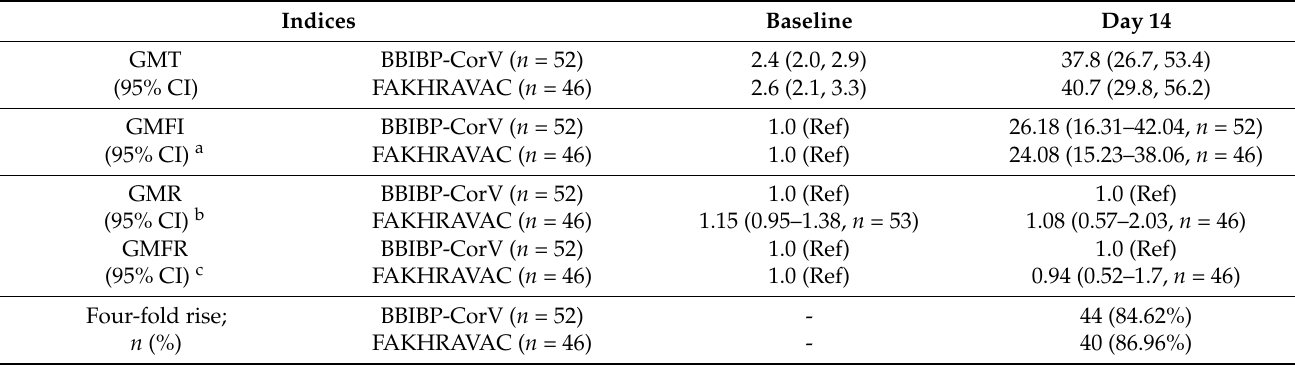
Table 3. Serum neutralizing antibody indices in seronegative group. a The geometric mean of the amount of antibody in each vaccine was divided by the amount of antibody in the baseline (i.e., Ref) day in the same vaccine group. b The geometric mean of the amount of antibody in each vaccine was divided by the amount of antibody in the BBIBP-CorV (Ref) group on the same day. c The ratio of the geometric mean changes of the two vaccines from the baseline (Ref) value was divided by the ratio of the changes in the BBIBP-CorV (Ref) group of baseline